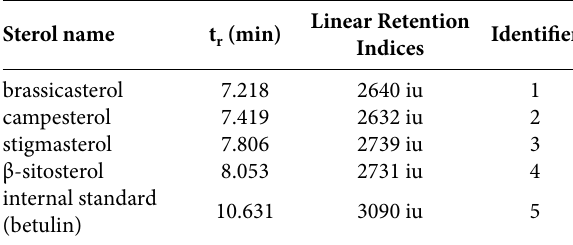
Table 1. Retention times for sterols and internal standard